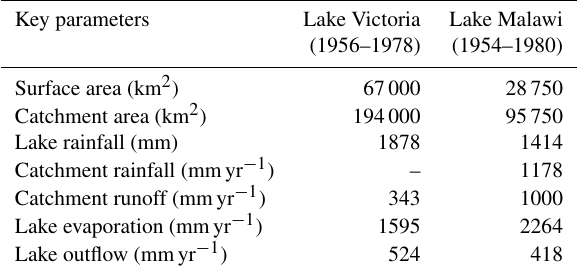
Table 1. Some key physical characteristics of Lake Victoria and Lake Malawi from various sources including Piper et al. (1986), Sutcliffe and Parks (1999) and Sene et al. (2017). All values indica- tive